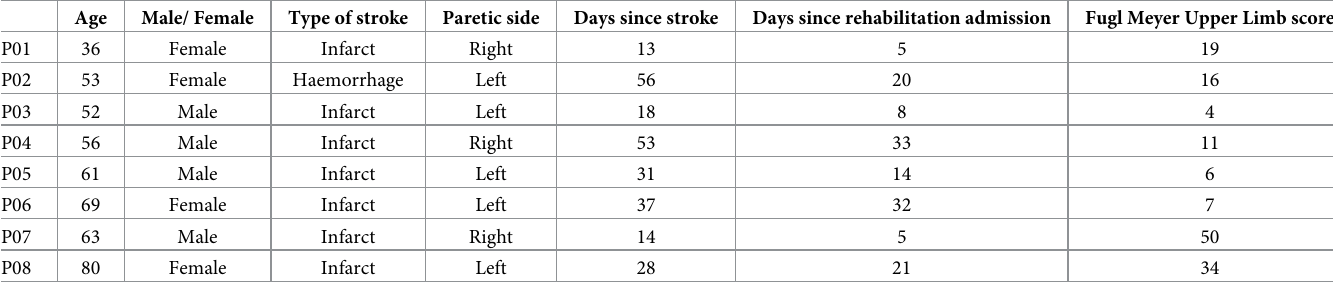
Table 3. Characteristics of stroke participants.